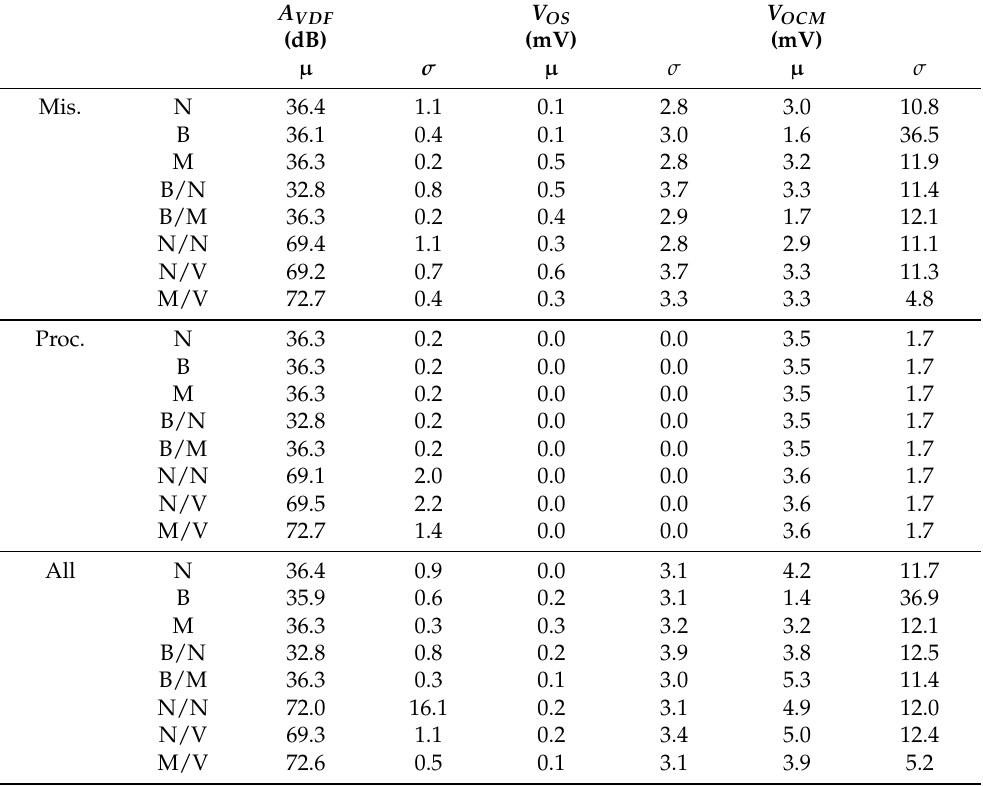
Table 4. OTA Monte Carlo simulation